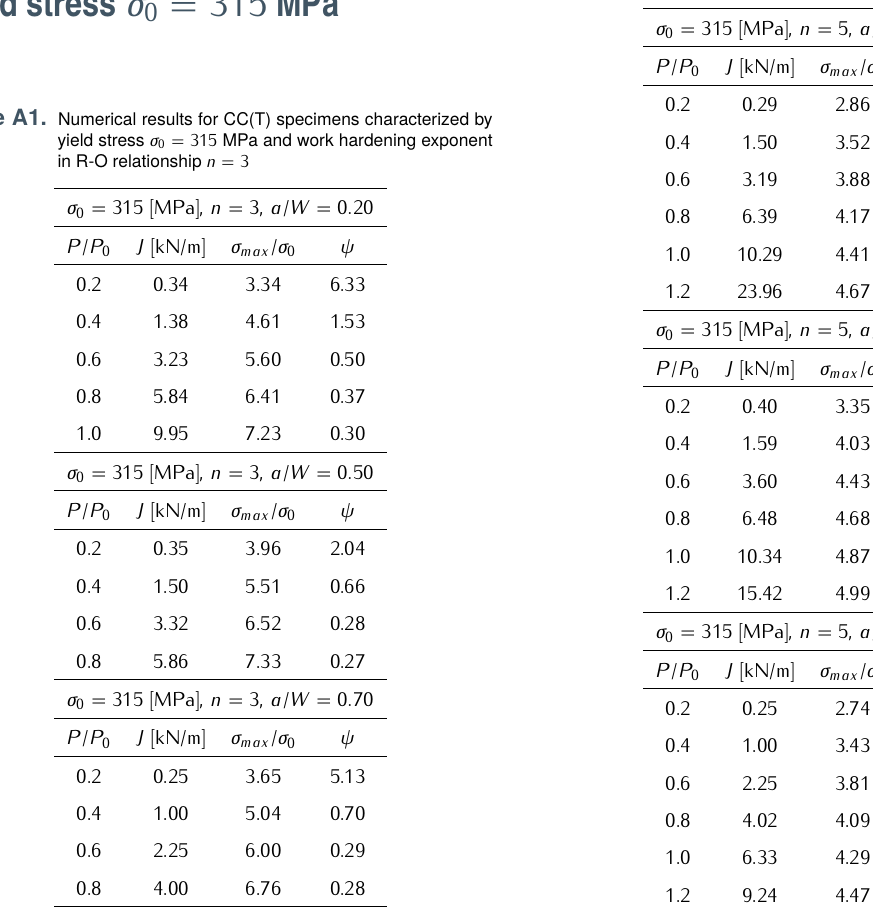
Table A2. Numerical results for CC(T) specimens characterized by yield stress σ MPa and work hardening exponent 0 = 315 in R-O relationship n =